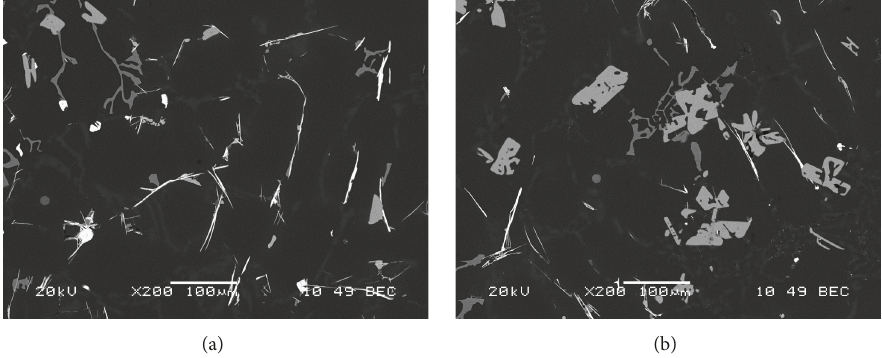
Figure 9: Backscattered electron images of base alloy + 1wt% Ce containing (a) 0.05 wt% Ti and (b) 0.15 wt%